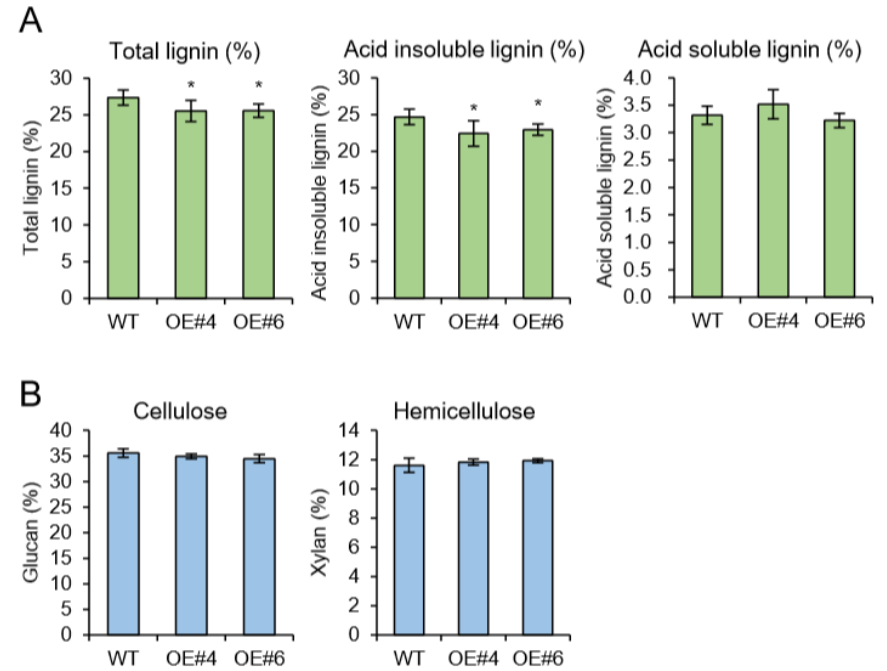
Figure 5. Cell wall carbohydrate ratio analysis (Klason assay) in 6-month-grown poplar. ( A ) Total lignin (acid insoluble) was decreased in OE lines. ( B ) Glucan and xylan ratios were not changed by overexpression of AtpPLAIIIα . Data represent the average ± SE from multiple independent replicates; n = 9 (WT), n = 3 (OE) at P < 0 . 05 (*).